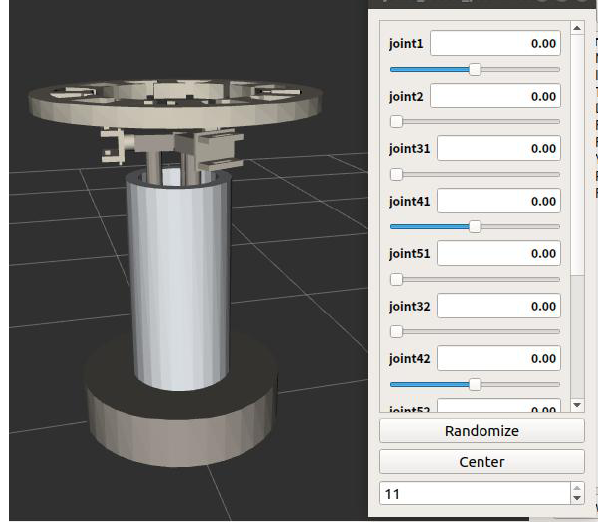
Figure 13. Link configuration